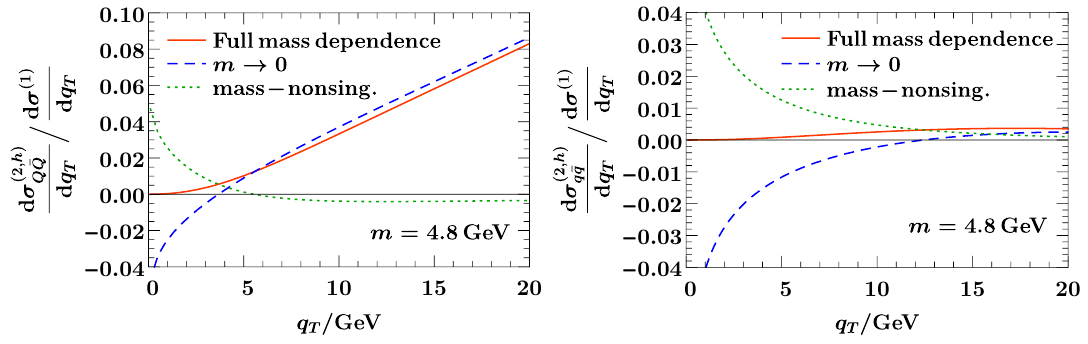
Figure 17 . Primary (left panel) and secondary (right panel) massive bottom quark contributions for the Z -boson q T spectrum at (cid:12)xed relative to the full